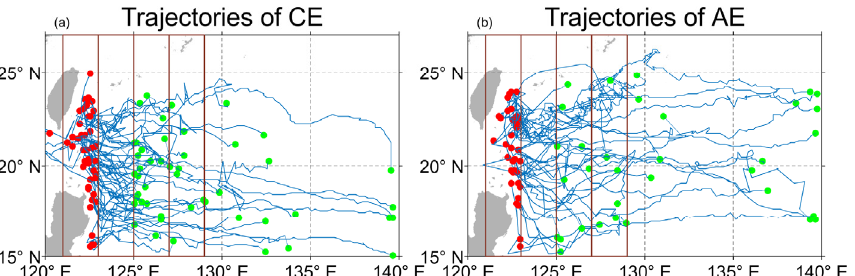
Figure 7. Trajectories of the detected ( a ) cyclonic and ( b ) anticyclonic eddies from the OFES dataset. Green (red) dots represent the locations of eddy generation (termination). Brown boxes represent the four longitudinal bands which are used for three-dimensional eddy composition.